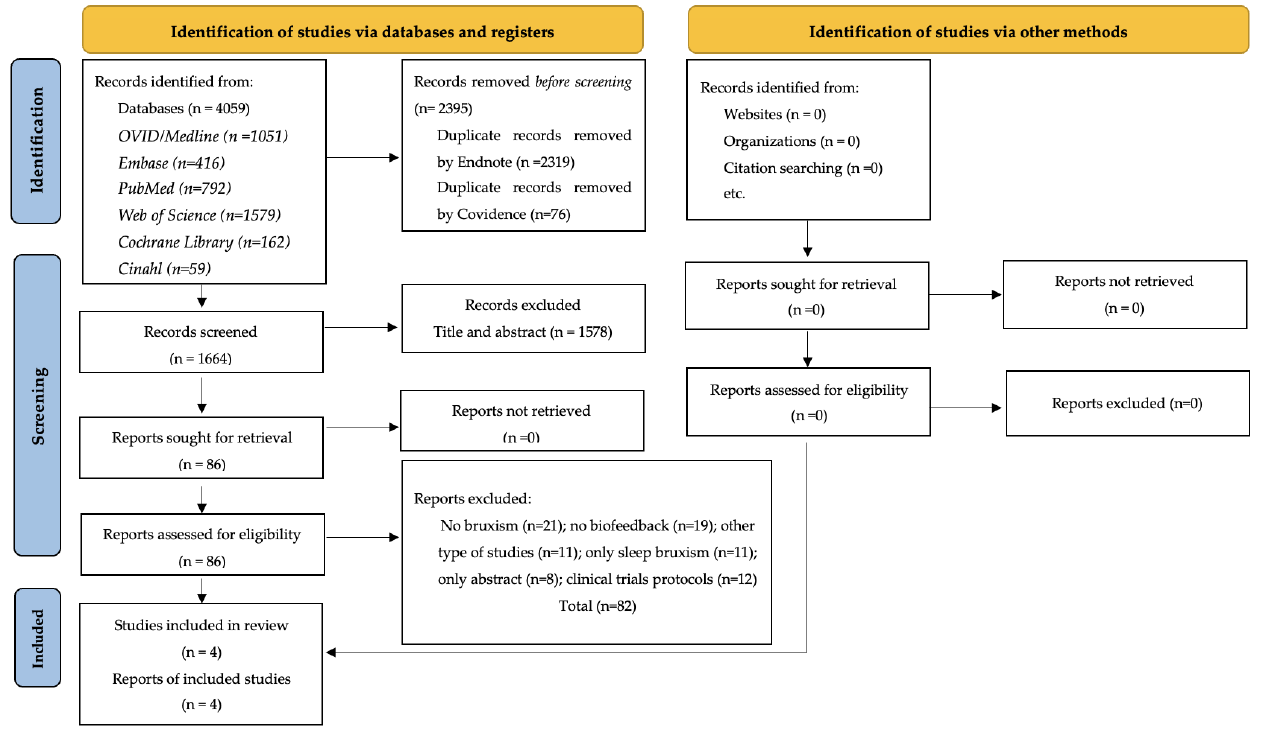
Figure 1. PRISMA Figure 1. PRISMA Flowdiagram. Table 1. Summary of the studies’ characteristics.